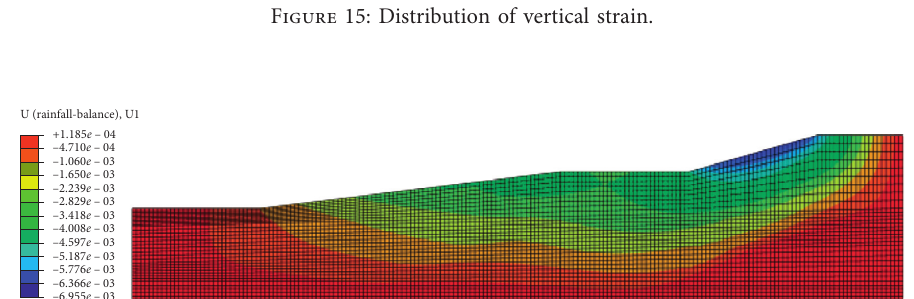
Figure 15: Distribution of vertical strain.